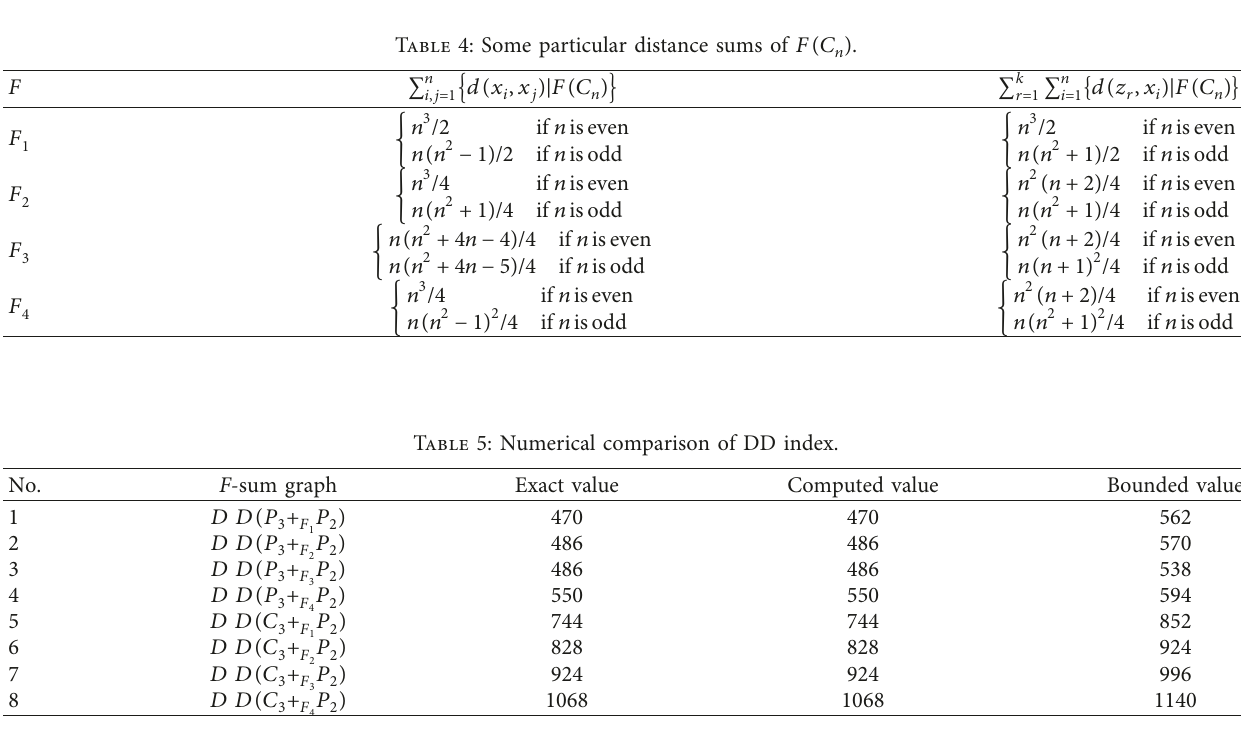
Table 3: WI and DDIs of F